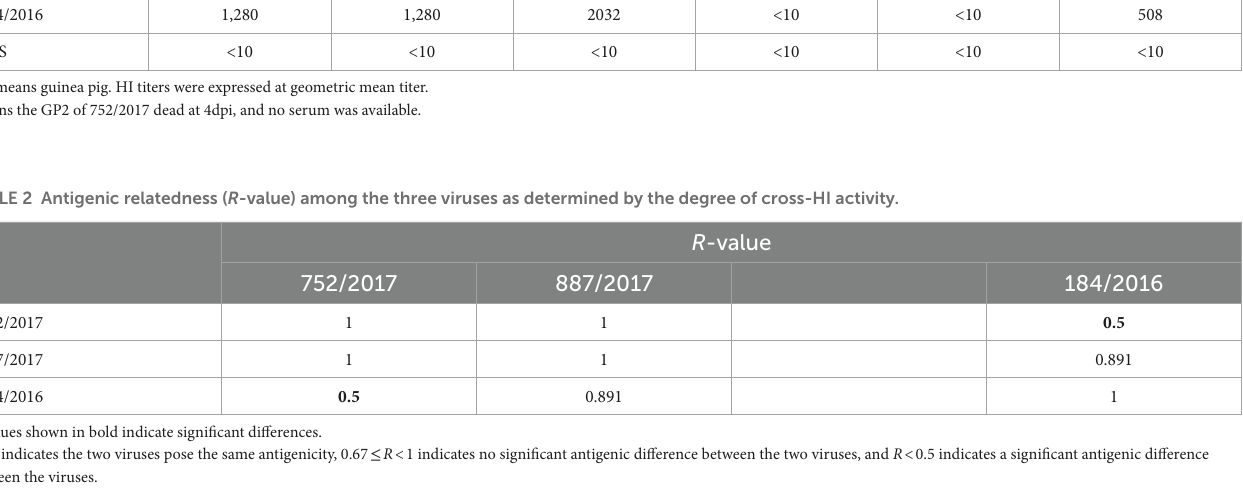
R -values shown in bold indicate significant differences. R = 1 indicates the two viruses pose the same antigenicity, 0.67 ≤ R < 1 indicates no significant antigenic difference between the two viruses, and R < 0.5 indicates a significant antigenic difference between the